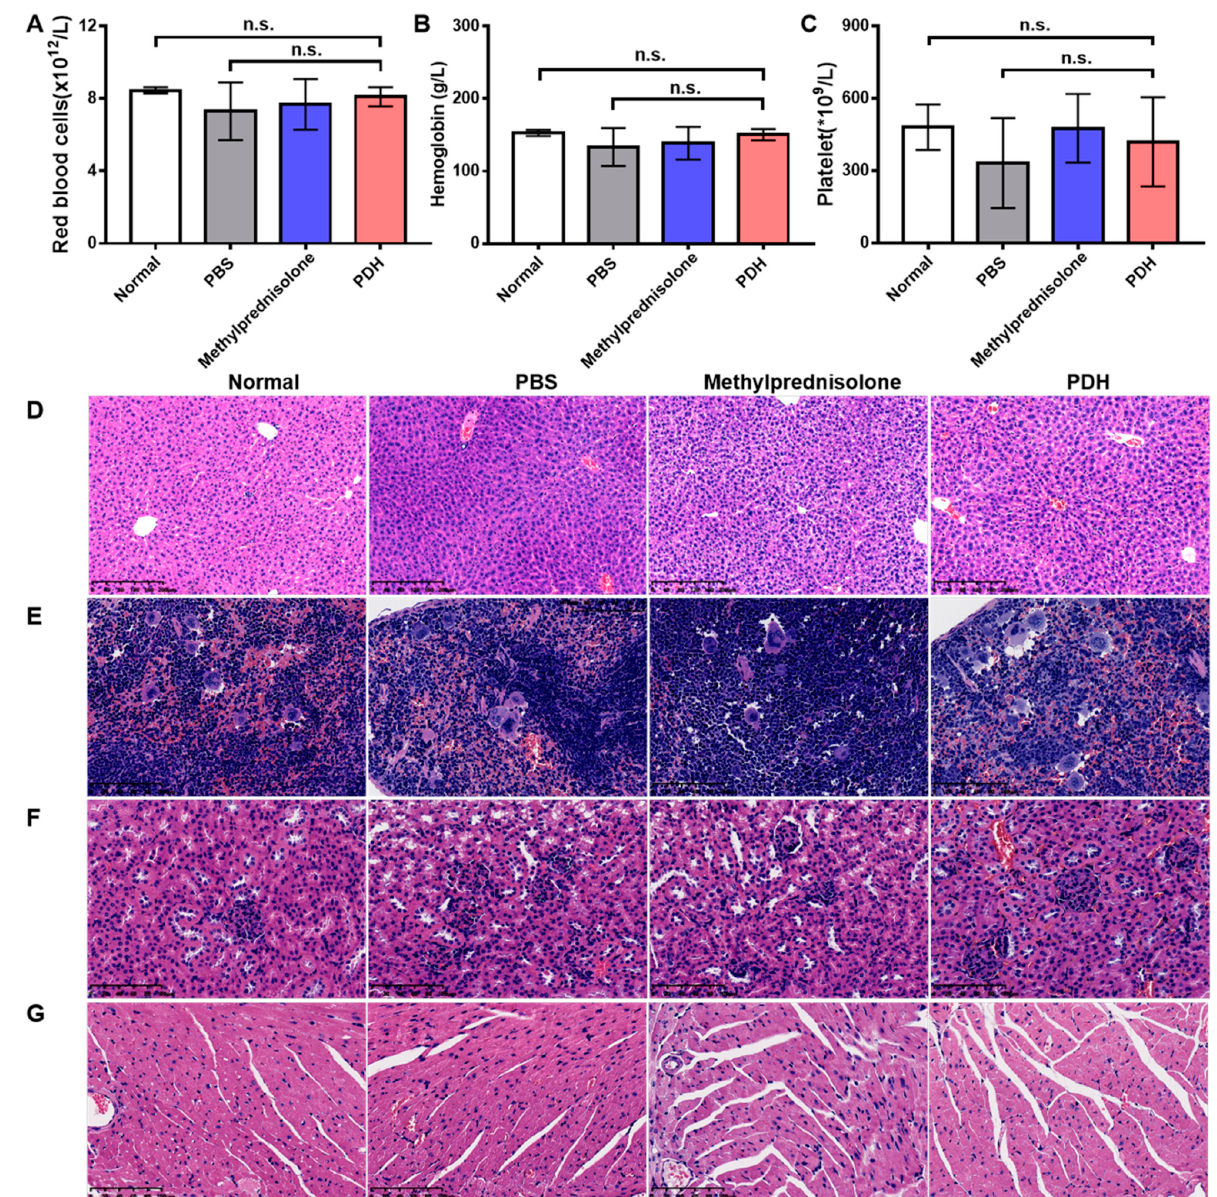
Figure 5. The biosafety of PDH nanoparticles in ALI mice. The changes in red blood cells ( A ), hemoglobin ( B ), and platelets ( C ) detected by automatic blood analyzer (n.s. is non-significant, n = 6). Representative images of liver (( D ) , scale bar = 200 μ m), spleen (( E ), scale bar = 100 μ m), kidney (( F ), scale bar = 100 μ m), and heart (( G ), scale bar = 100 μ m) identified with hematoxylin and eosin staining.